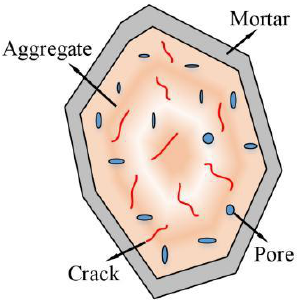
Figure 1. Recycled concrete aggregates.